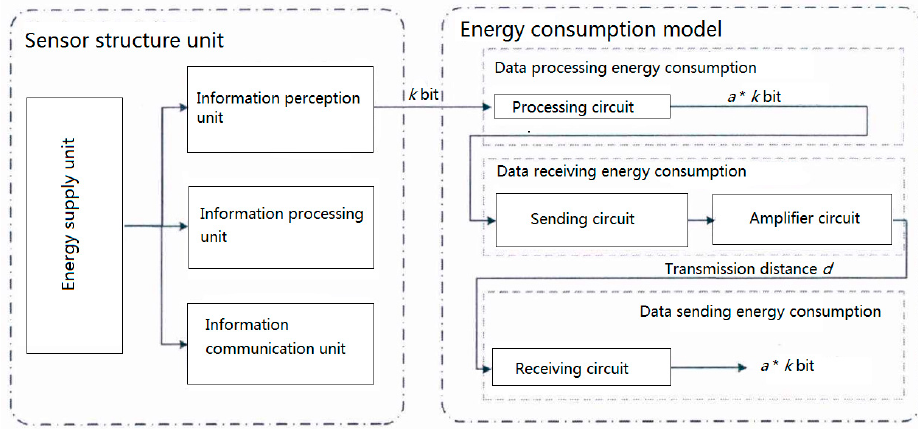
Figure 3. Composition structure and energy consumption of wireless sensor nodes.